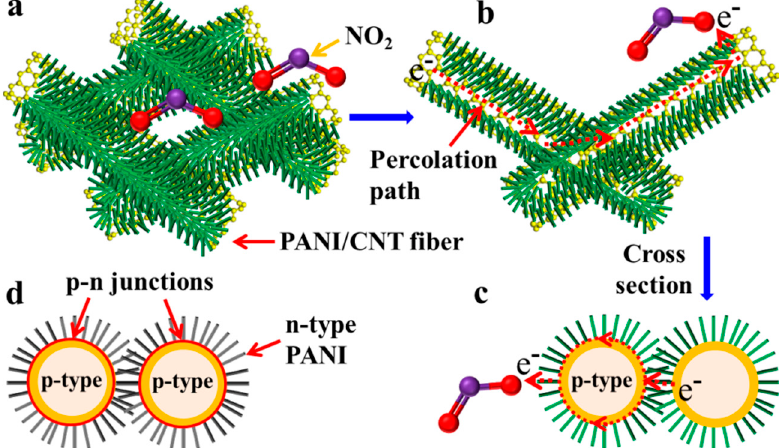
Figure 8. Possible sensing mechanism ( a ) sketch diagram of conductive network of hierarchical p-PANI/CNT fibers, ( b ) percolation path through conjugate interfaces of PANI and MWCNTs, ( c ) cross section of PANI/CNT fibers and ( d ) p–n heterojunction structure of hierarchical n-PANI/CNT fibers.